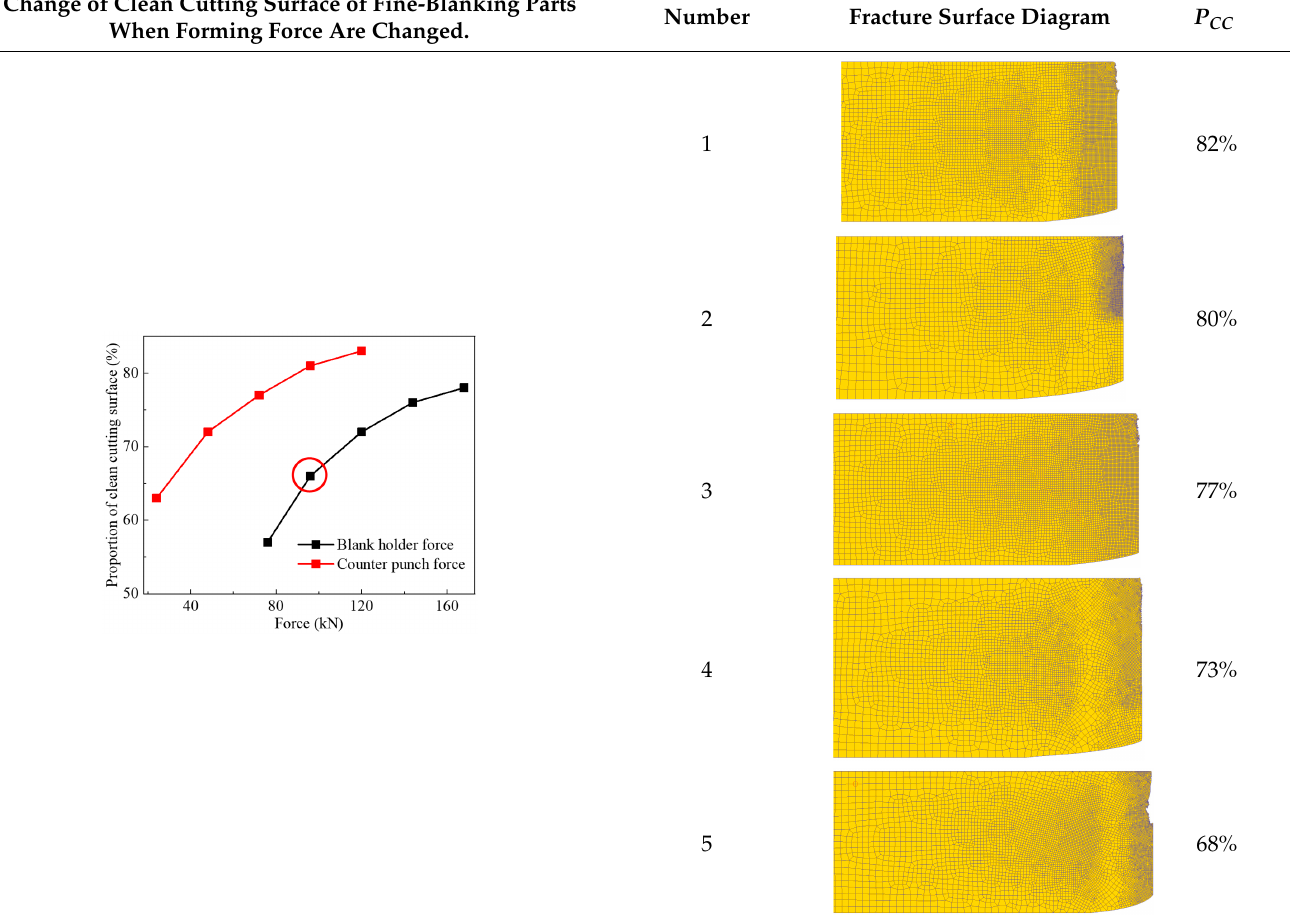
Figure 4. Influence of forming force changes on die load: ( a ) changes of die load when blank hold- er force is changed; ( b ) changes of die load when counter punch force is changed.